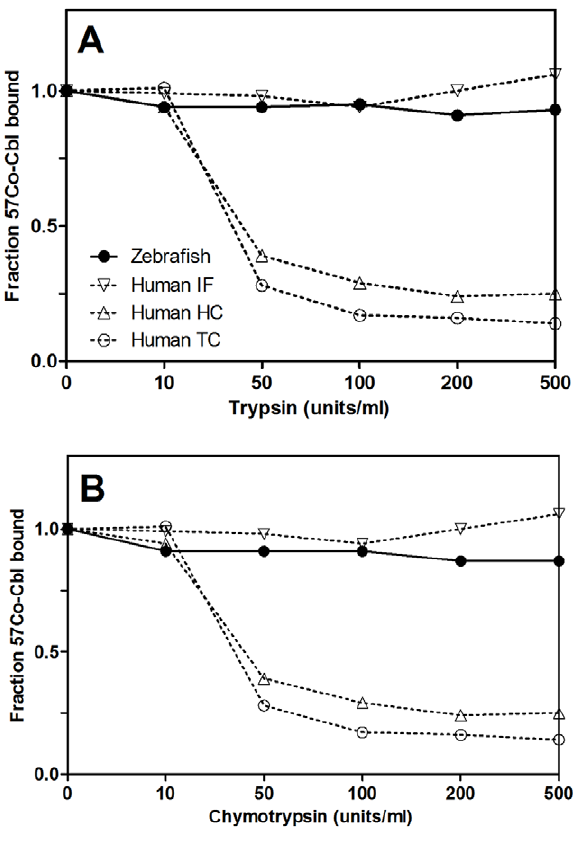
Figure 2. Sensitivity of the Zebrafish Cobalamin Binder toward Degradation by Trypsin and Chymotrypsin. The cobalamin binder from zebrafish and human TC, HC, and IF were incubated with 57 [Co]- cobalamin for 30 minutes before addition of increasing concentrations of trypsin and chymotrypsin (incubation for 18 hours at 37 u C). Protein- bound 57 [Co]-cobalamin was measured after removal of free cobalamin by charcoal precipitation, and the amount of 57 [Co]-cobalamin bound was expressed relative to the amount bound when only 57 [Co]- cobalamin was present.